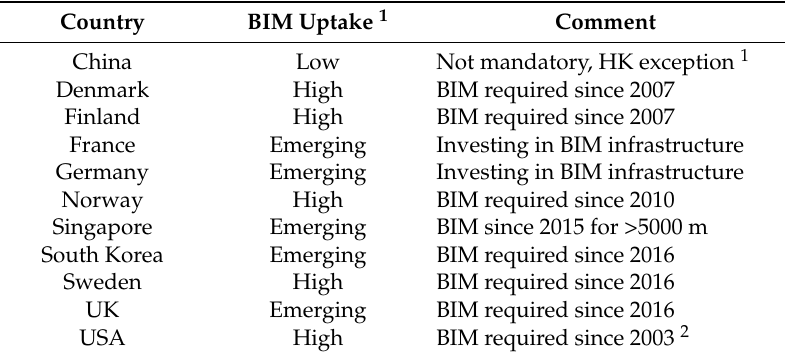
Table 1. BIM uptake by government jurisdictions internationally (15, 16]. Country BIM Uptake 1 Comment China Low Not mandatory, HK exception 1 Denmark High BIM required since 2007 High BIM required since 2007